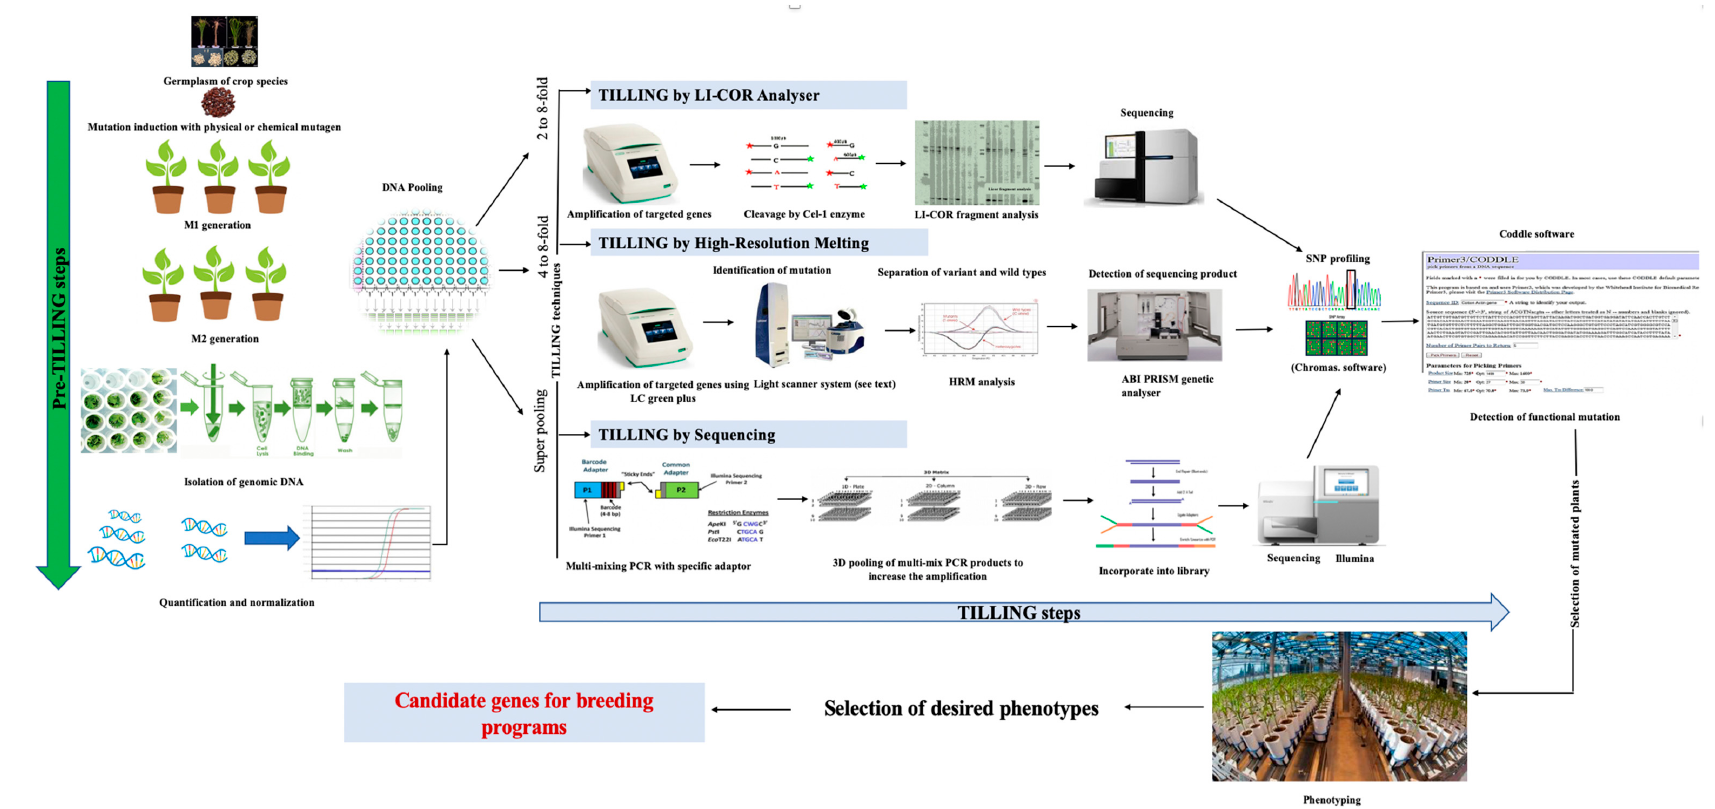
Figure 1. Schematic workflow of TILLING by CEL-1 enzyme, TILLING by high-resolution melting, and TILLING by sequencing (TbyS).